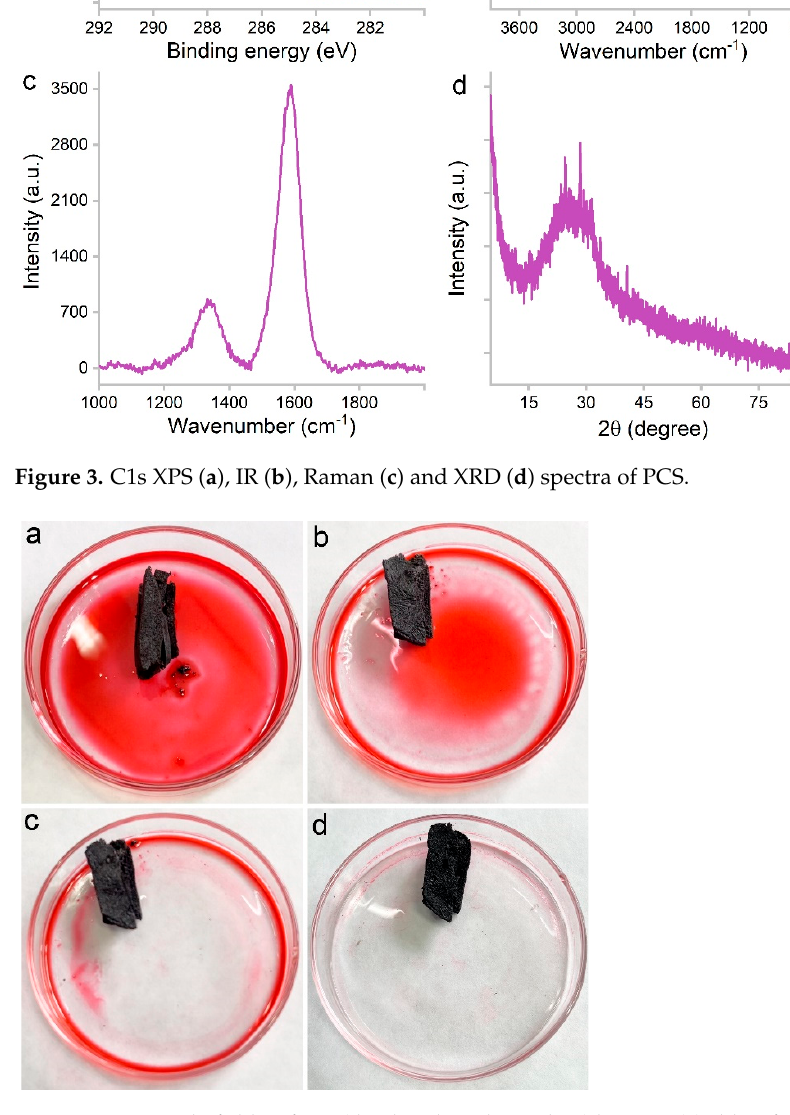
Figure 3. C1s XPS ( a ), IR ( b ), Raman ( c ) and XRD ( d ) spectra of PCS.